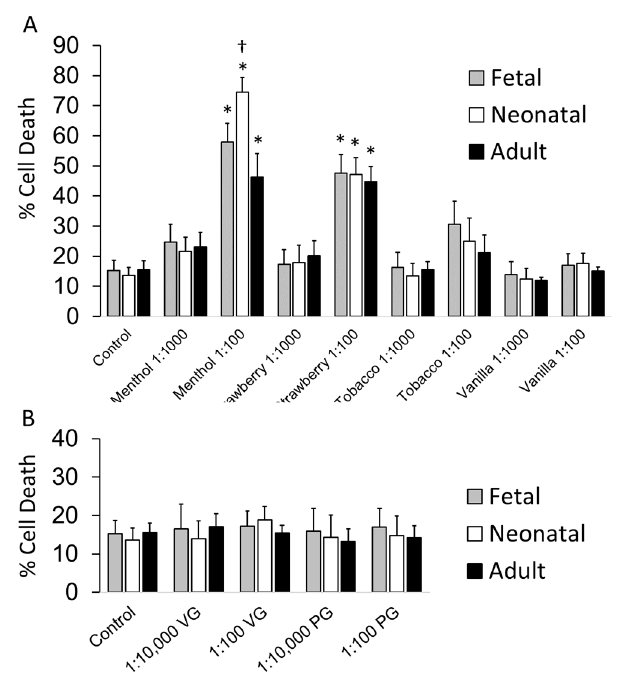
Figure 2. Exposure to select flavored solutions induced cell death in pulmonary artery smooth muscle cells (PASMC). PASMC isolated from fetal, neonatal, and adult ovine lungs were treated with variable concentrations of flavored solutions or pure vegetable glycerin (VG) / propylene glycol (PG) for 24 h. ( A ) The 1:100 dilution of menthol and strawberry resulted in significant increase in cell death as compared to untreated controls (* p < 0.05). Immature cells were more susceptible to menthol toxicities ( † p < 0.05 as compared to adult). ( B ) The 1:100 and the 1:10,000 VG and PG exposure did not result in significant increase in cell death. Data are presented as mean + SEM. n ≥ 6. Table 2. Immature PASMC demonstrated increased susceptibility to flavored solutions by calculated LD50s. Cell death documented by lactate dehydrogenase (LDH) assay at variable dosing was used to calculate concentration at which 50% cell death would occur (lethal dose or LD50). Lower LD50s were noted for fetal and neonatal cells consistent with increased susceptibility. .